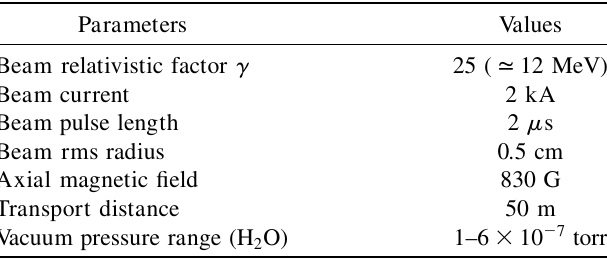
TABLE I. Parameters for comparison of PIC and spread- mass models.